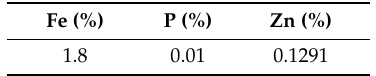
Table 2. Composition of Cu matrix in alloying element-depleted regions.